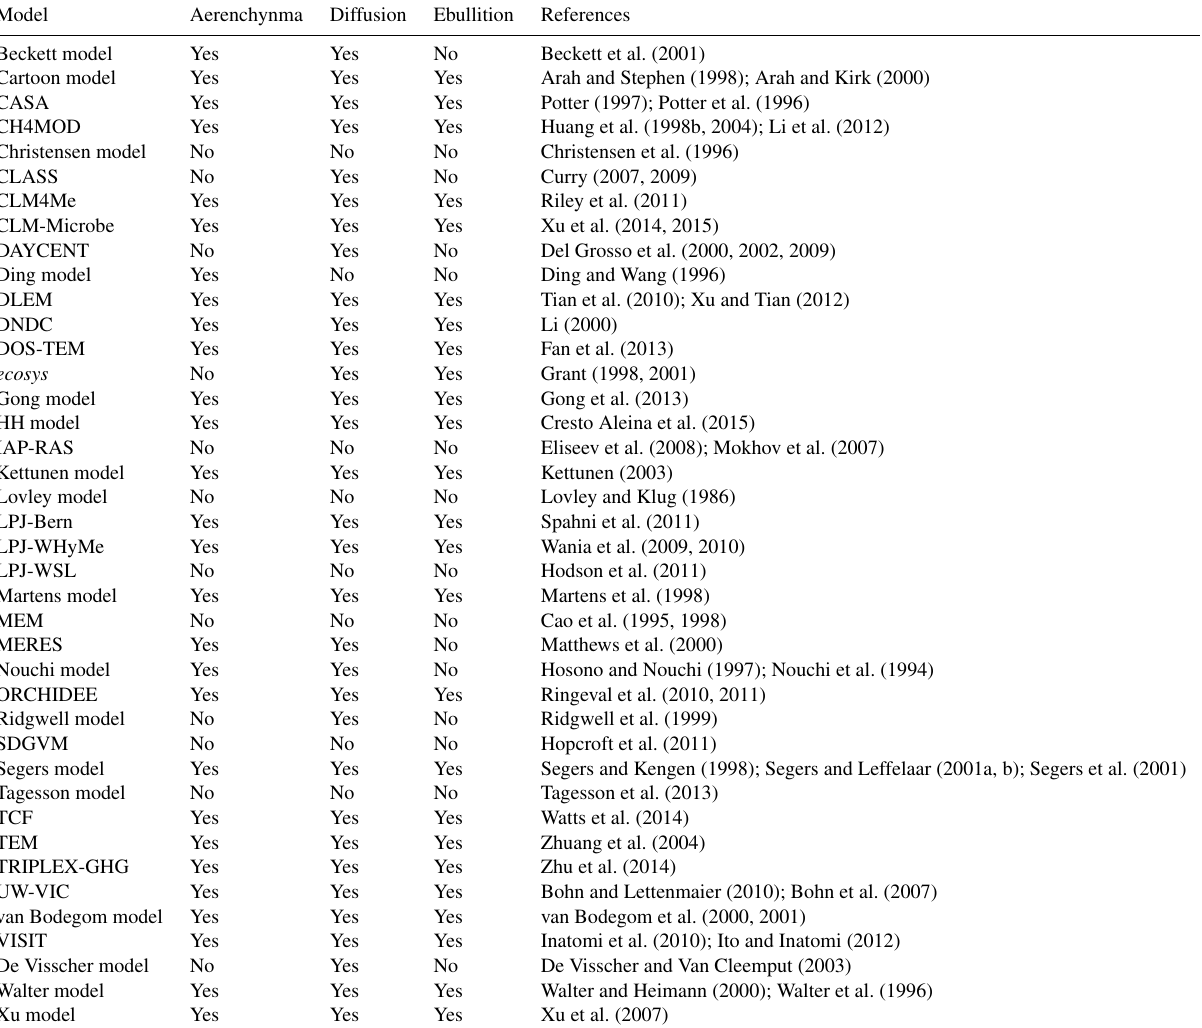
Table 1. Terrestrial ecosystem models for CH 4 cycling and the model representation of three pathways of CH 4 transport (models are in alphabetical order; author’s last name is used if the model name is not